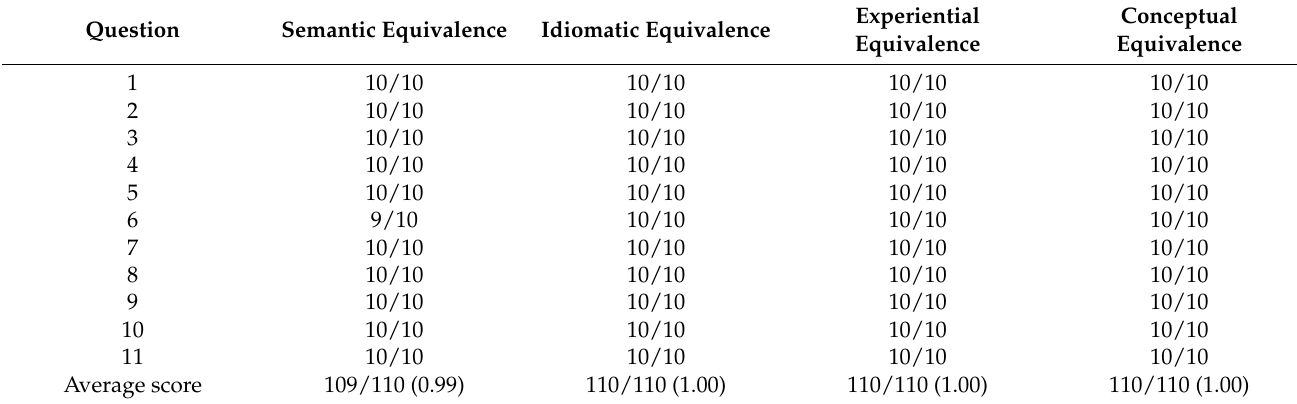
Table A1. Evaluation Score of the Expert Committee for the Second GMAS (after